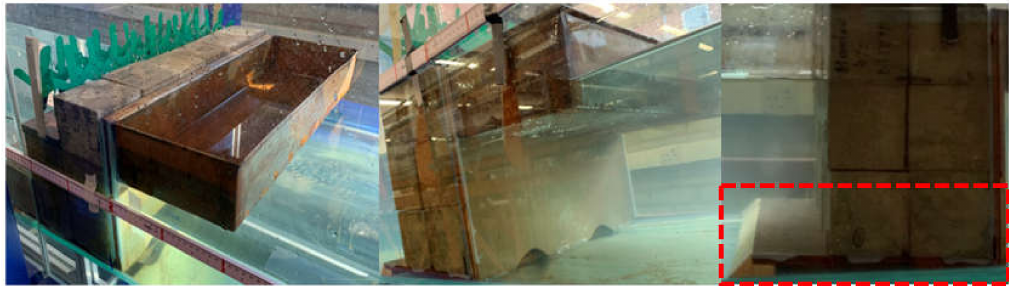
Figure 4. Overtopping collection device. The red box highlights the testing